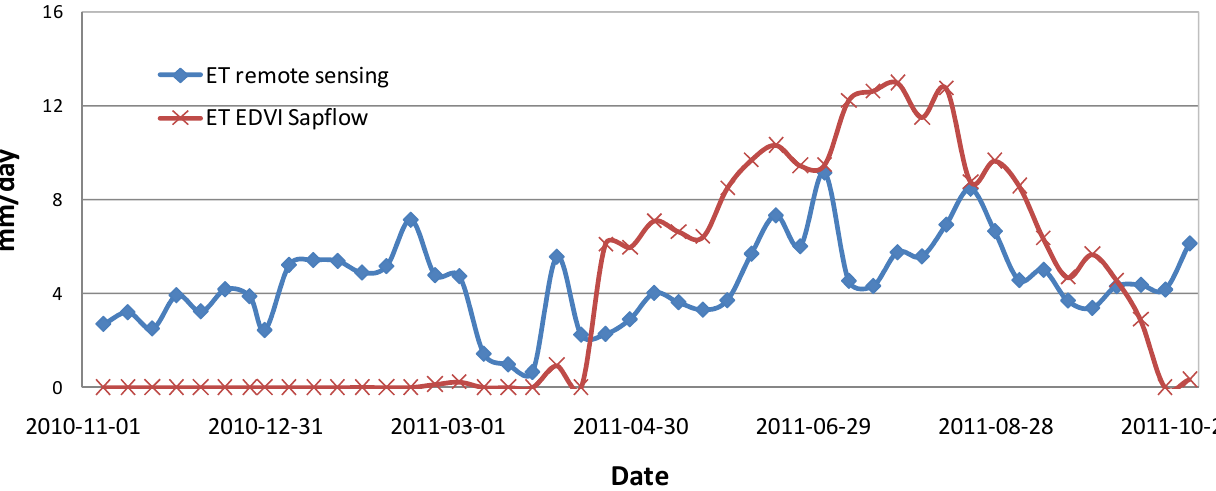
Figure 5. Comparison of evapotranspiration estimated by remote sensing and calculated by upscaling approach with NDVI and sap flow measurements from November 2010 to October